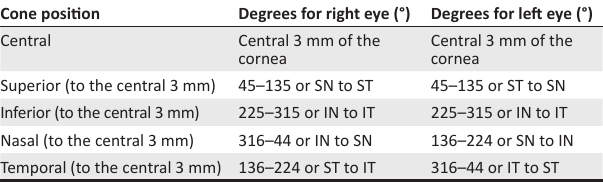
TABLE 2: Location of the cone (not the corneal apex) for right and left eye using the degree scale. Cone